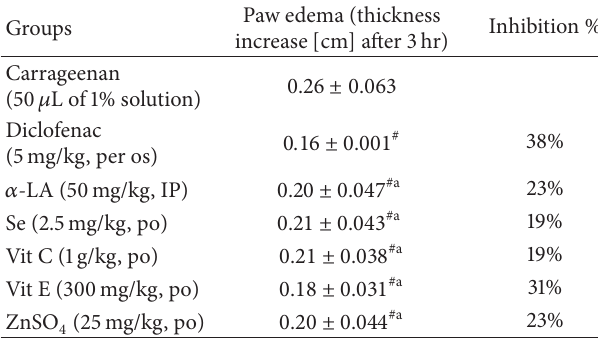
Table 1: Effects of diclofenac, 𝛼 -LA, selenite, Vit C, Vit E, or zinc on paw thickness increase after 3hr in a rat carrageenan-induced paw edema